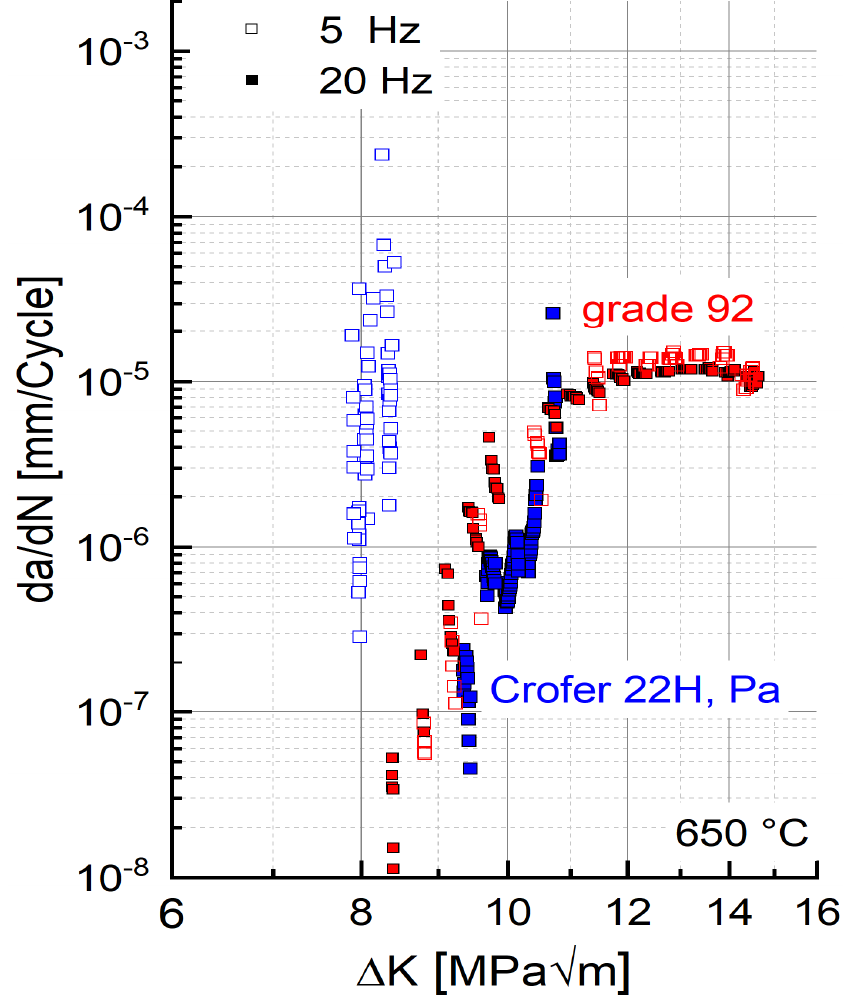
Figure 6. Threshold behaviour of precipitation-annealed Crofer ® 22H (PA) and grade 92 at 650 °C.